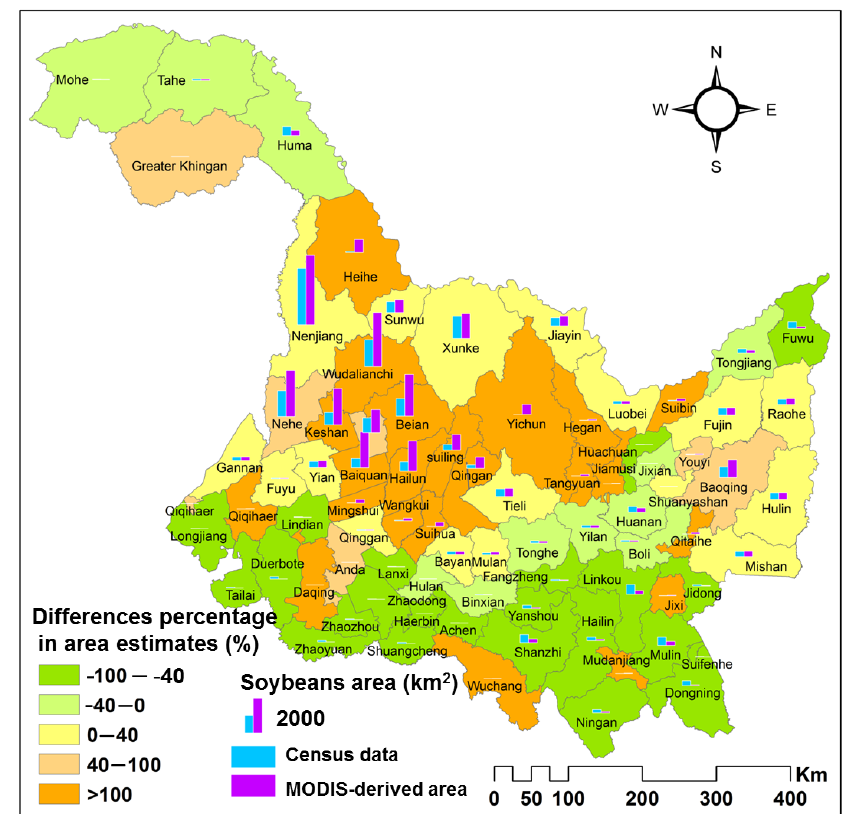
Figure 11. The spatial distribution of agreement between MODIS-based result and census data on soybean cultivation area for each county in Heilongjiang Province. The colors show the percentage (%) differences between the two estimates and the accompanying bar plots show the actual area comparison of the two estimates (km 2 ).